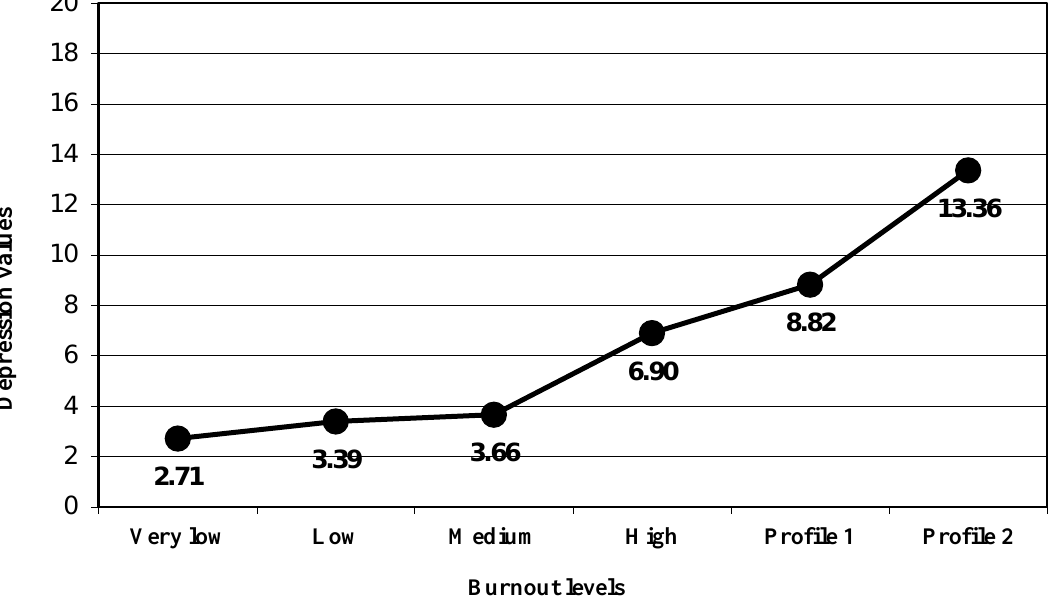
Figure 1. Mean in the depression variable for the groups of burnout levels.